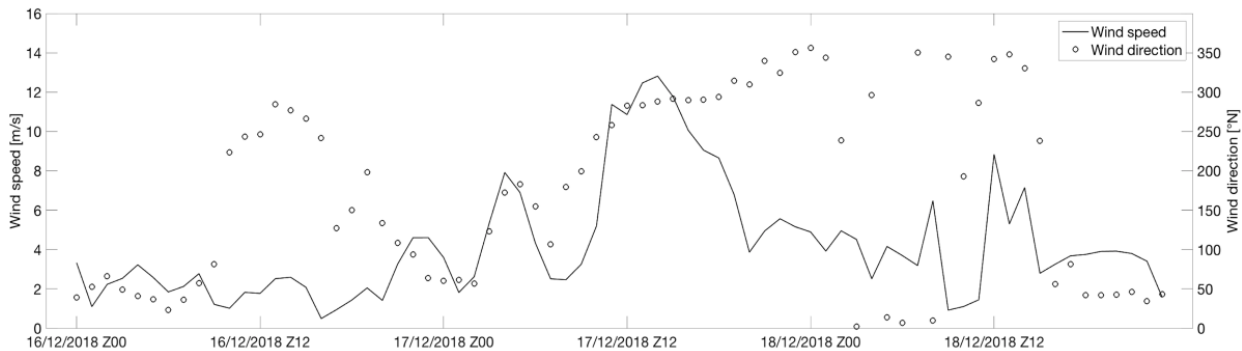
Figure 4. Calculation of wind speed (solid line) and wind direction (circles) in the study area between 16 and 18 December 2018. The simulation was performed using the WRF numerical model.